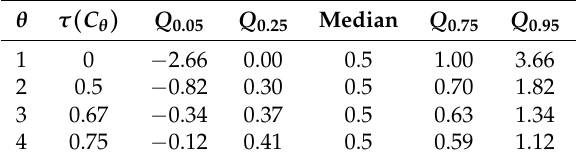
Table 8. Some percentiles of Y = X 1 / ( X 1 + X 2 ) , where ( X 1 , X 2 ) follows Gumbel Copulas. θ τ ( C θ ) Q